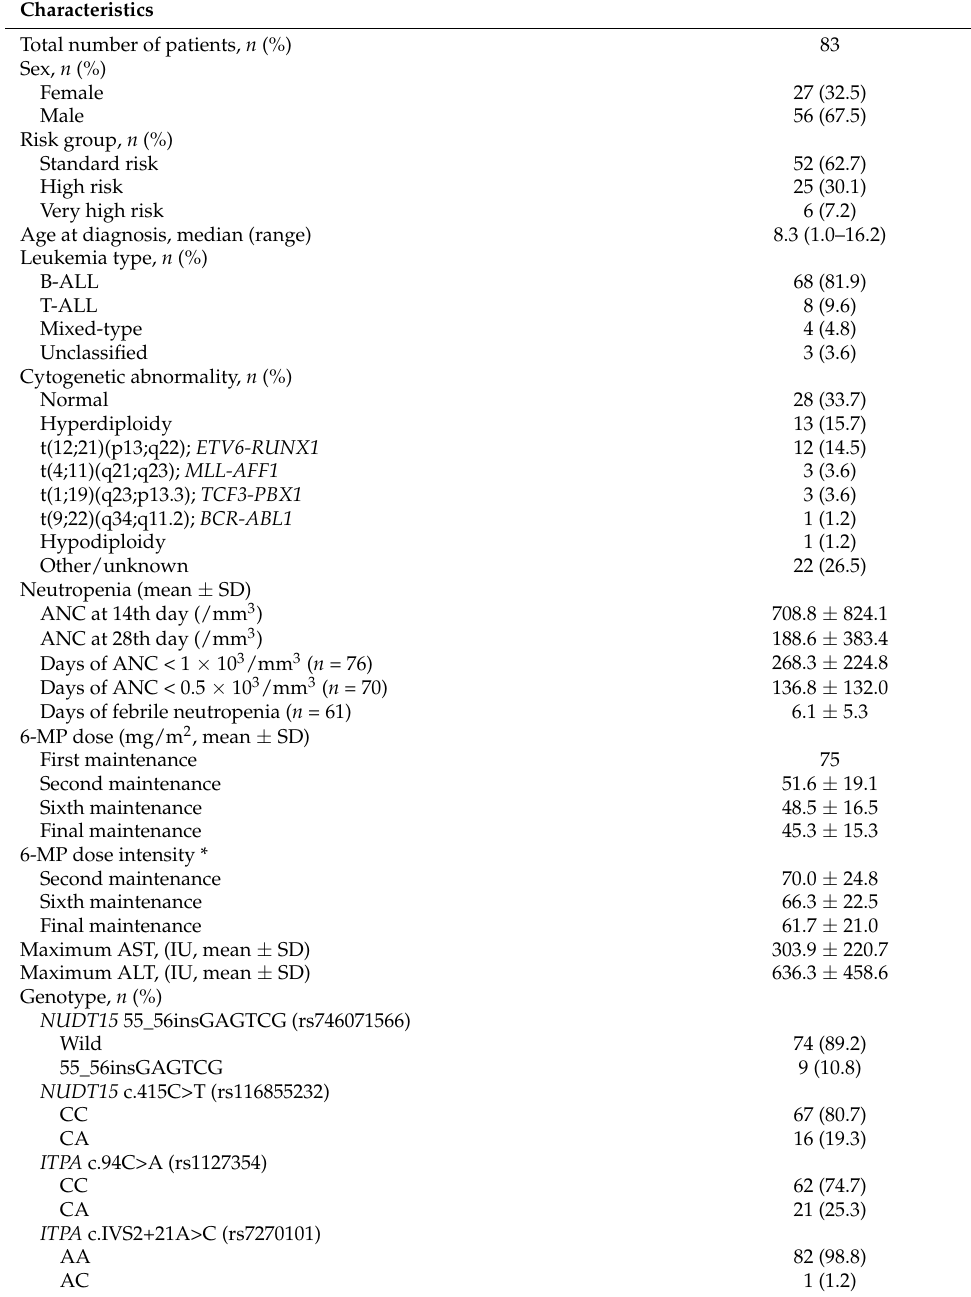
Table 1. Characteristics and genotype frequencies of pediatric acute lymphoblastic leukemia patients enrolled in this